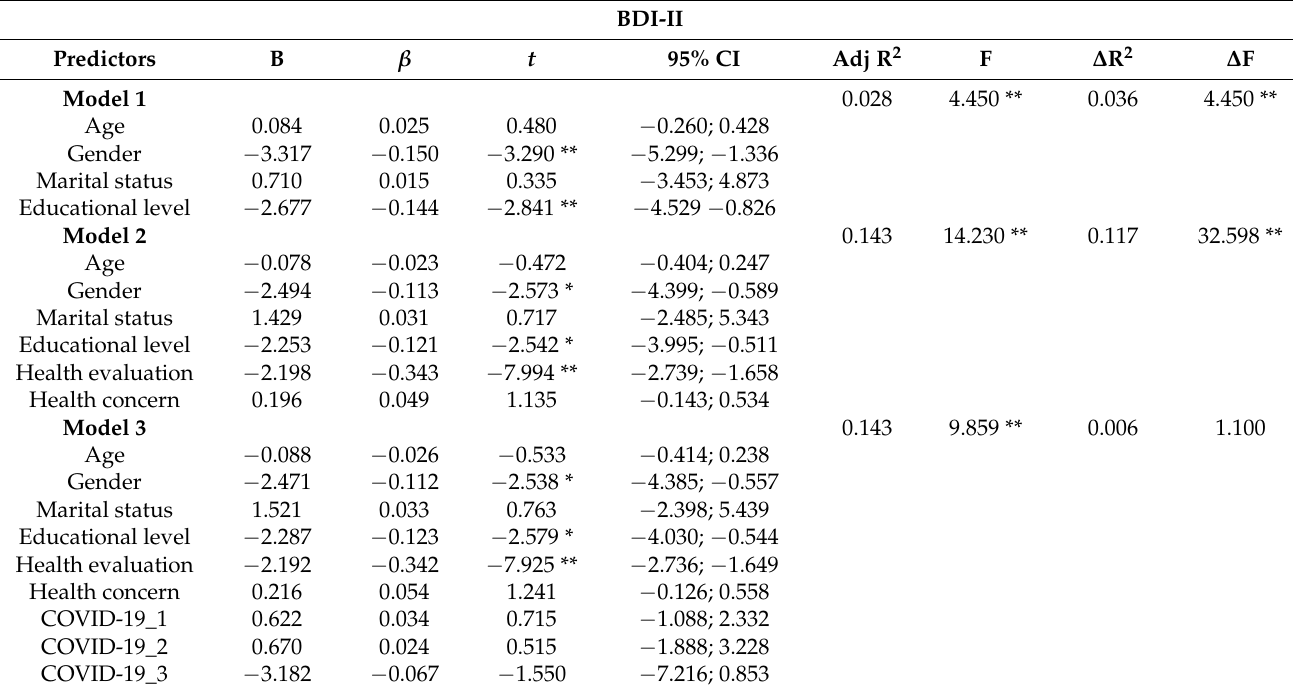
BDI-II = Beck Depression Inventory; CI = confidence interval; COVID-19_1 = knowing of others who tested positive for COVID-19; COVID-19_2 = knowing of others who died of COVID-19; COVID-19_3 = having had contact with others who tested positive for COVID-19. * p < 0.05; ** p <